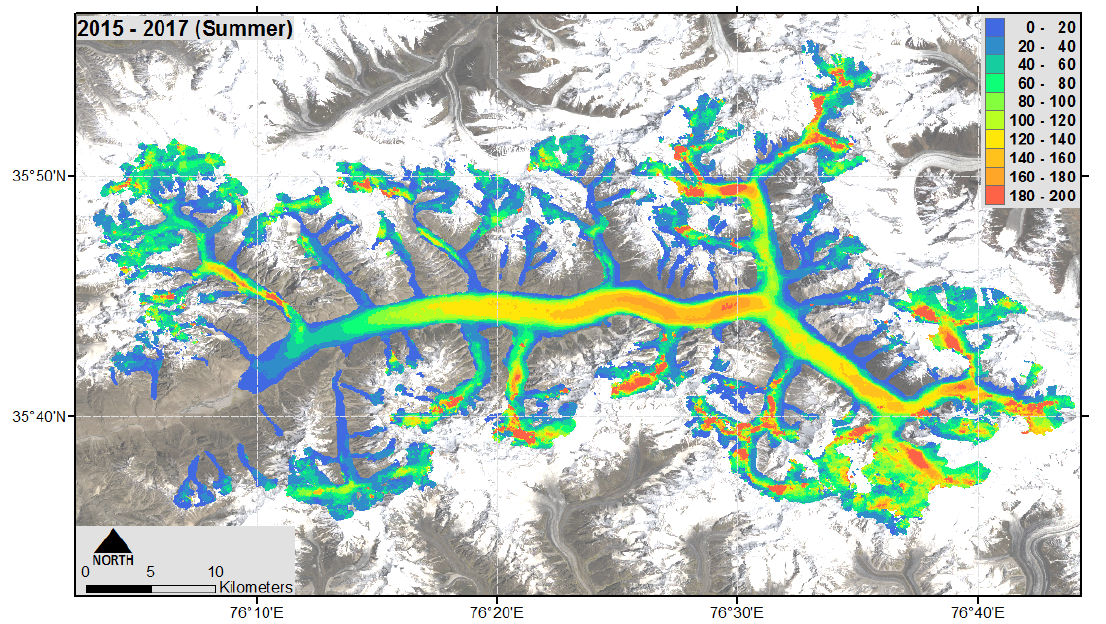
Figure A3. Averaged velocity field of all summer surface velocities (m a − 1 ) for the period 2015 to